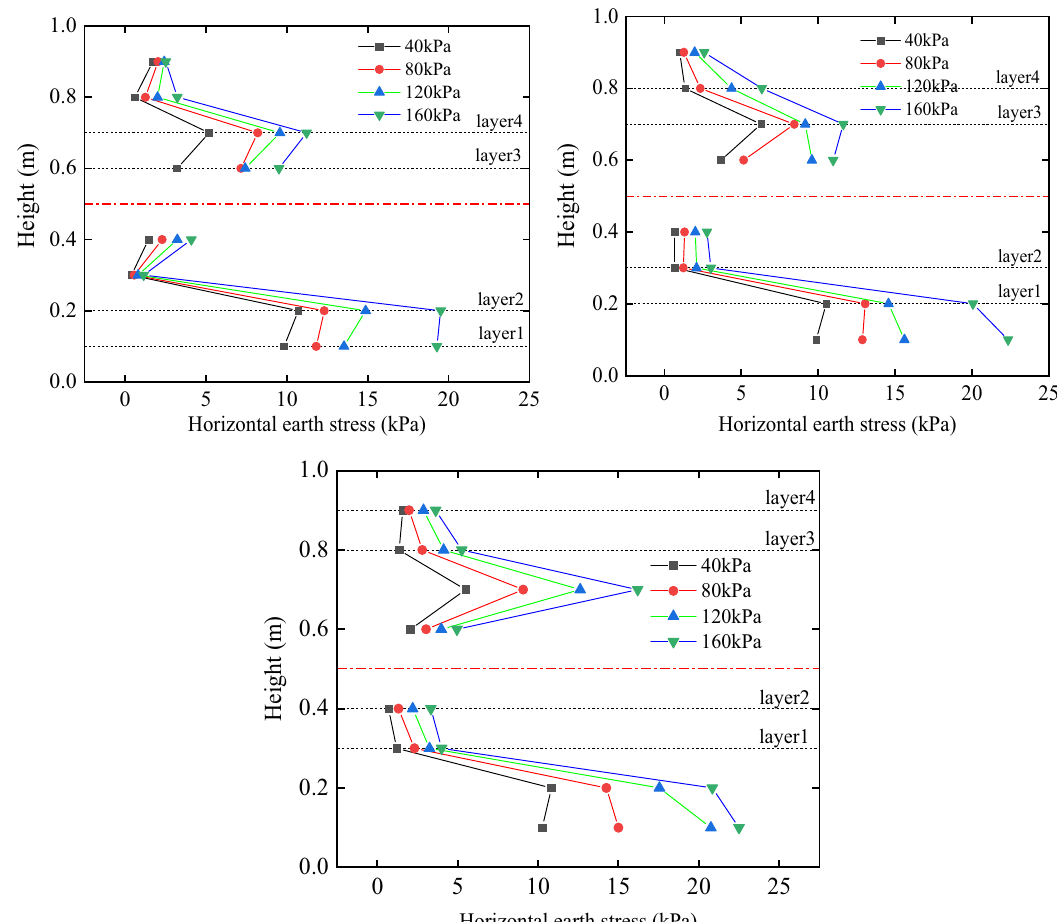
Figure 8: Horizontal earth pressure on wall back under three working conditions, D2 ( upper - left ) , M2 ( upper - right ) , and U2 ( bottom )